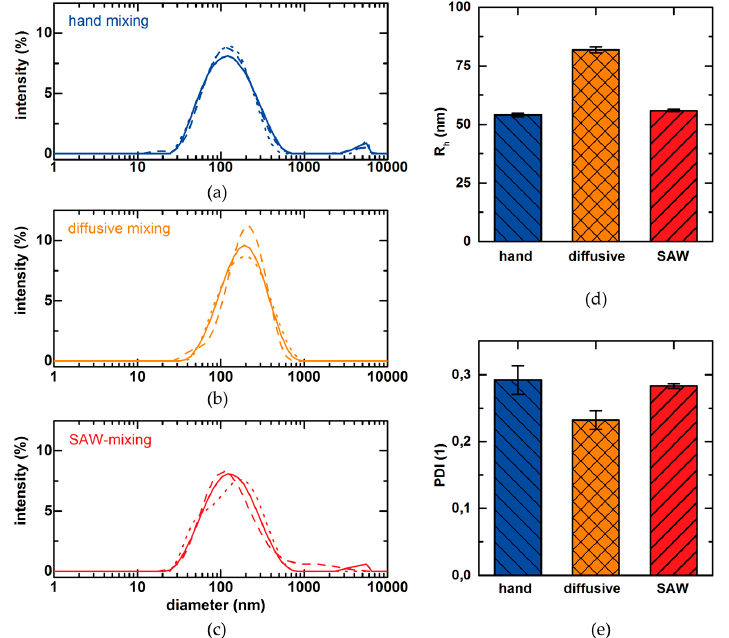
Figure 8. Size distribution of particles from bPEI and pDNA mixed: ( a ) in bulk; ( b ) in a 3-in-1-channel by diffusive mixing without applied SAW; ( c ) in a 3-in-1-channel with applied SAW (solid, dashed and dotted lines show the results of three measurements); ( d ) Hydrodynamic Radii R h determined by DLS; ( e ) PDI of the according particles from ( a – c ).